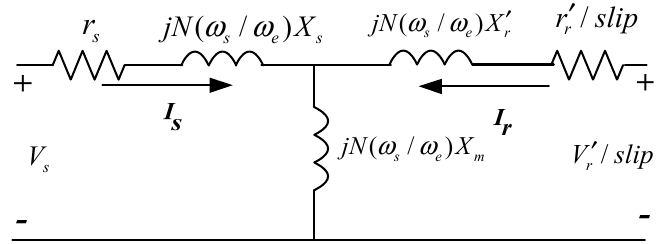
Figure 2. The steady state circuit model of